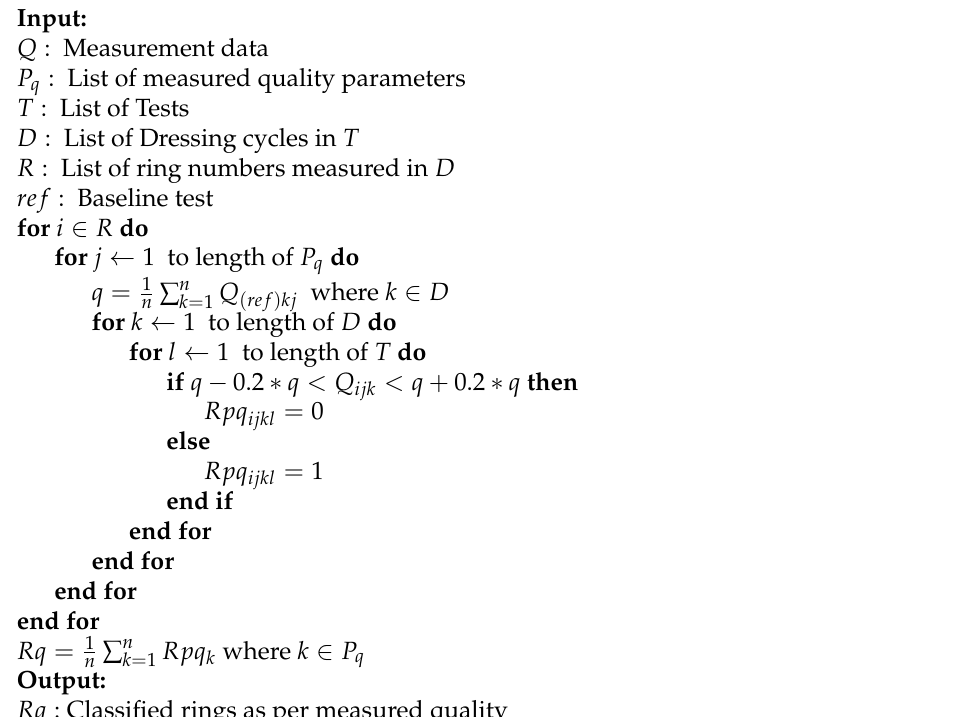
Algorithm 1 Calculating acceptable quality criteria based on the measured quality